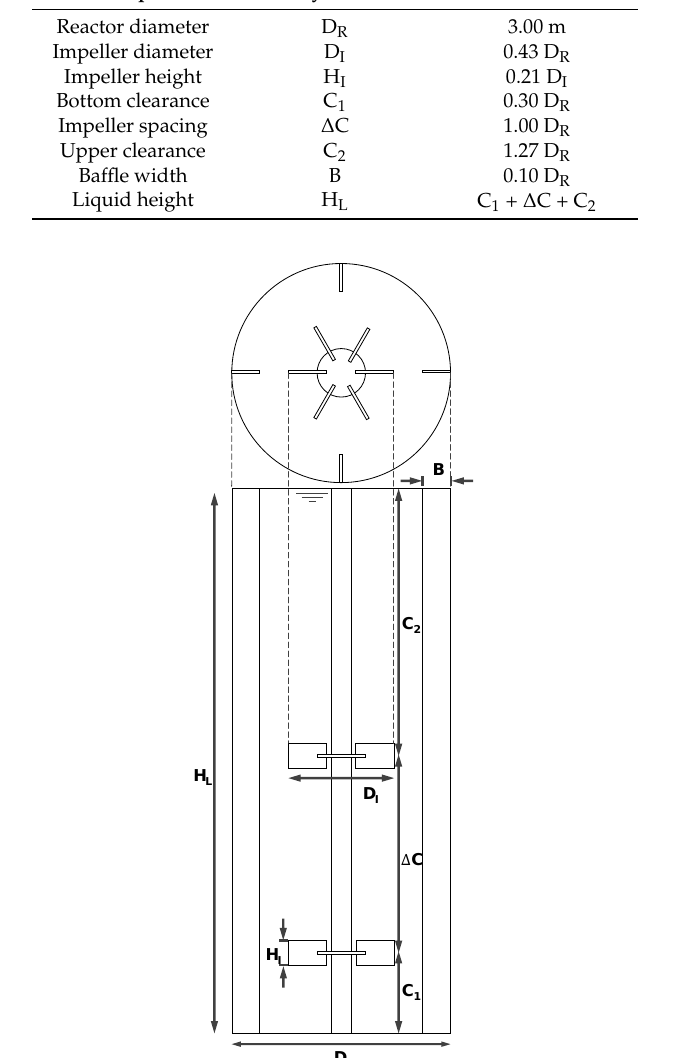
Figure A1. Schematic diagram of reactor geometry derived from Haringa et al. [21]. The stirred tank reactor contains four baffles and two Rushton turbines with eight blades ( bottom ) and six blades ( top ). Dimensions indicated by capital letters are explained in Table A1.